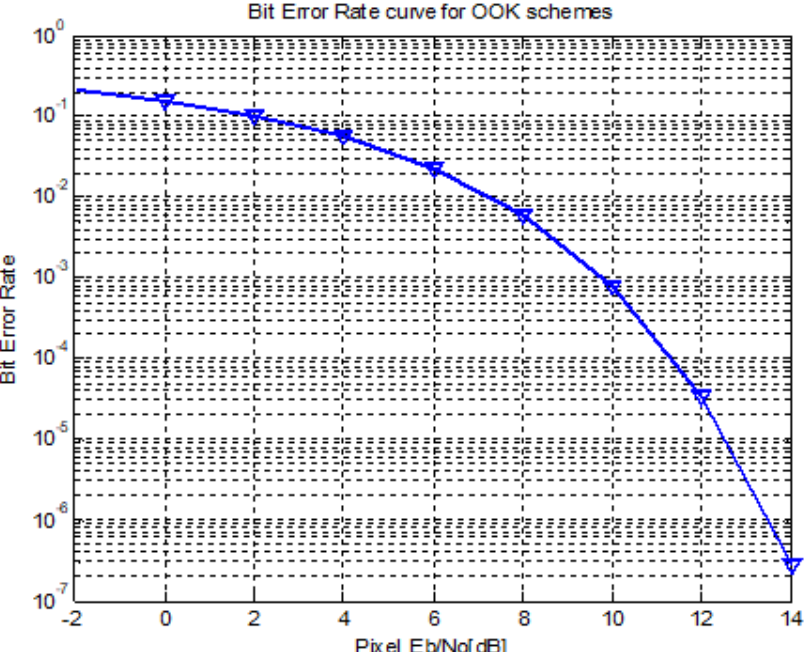
Figure 11. The BER curve for the optical OOK modulation.